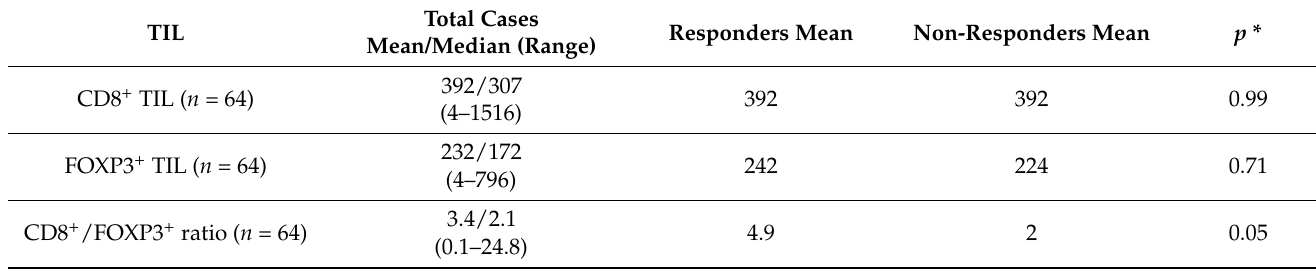
Table 3. Tumor-infiltrating lymphocytes (TIL) count per mm 2 in tumor samples and its relationship with response to induction